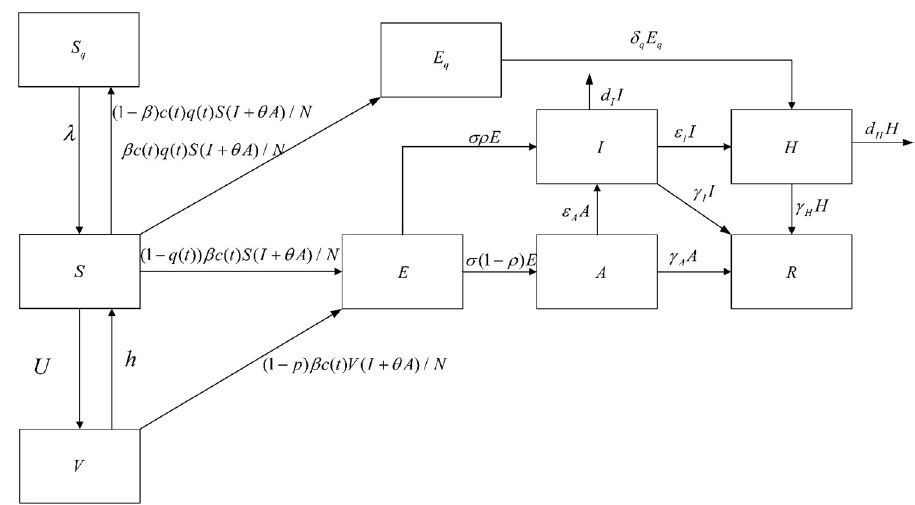
Fig 1. The transmission diagram for model